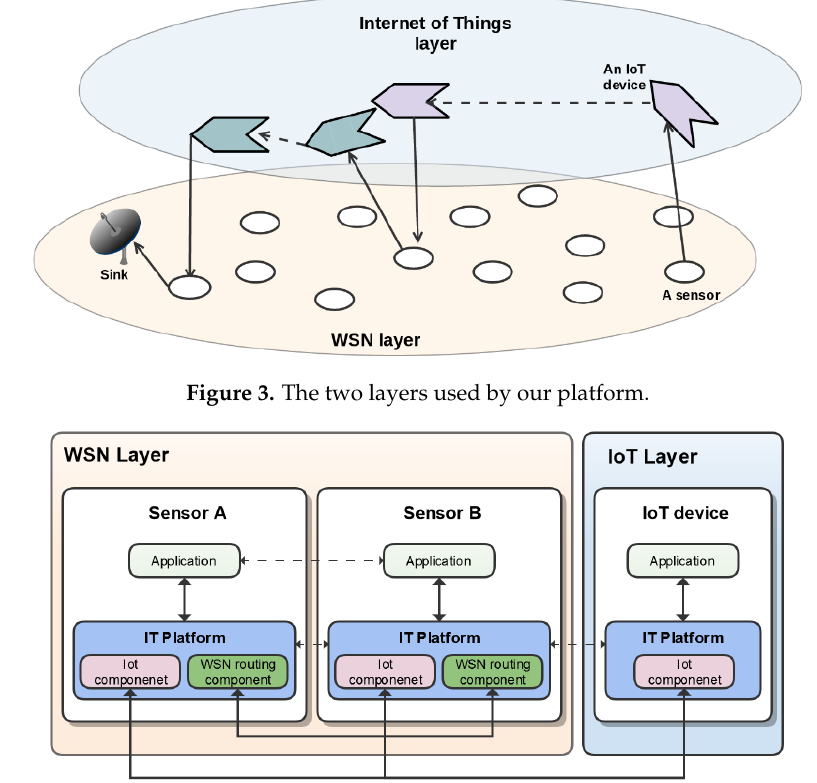
Figure 4. The internal architecture of a Sensor and an Internet of Things (IoT)